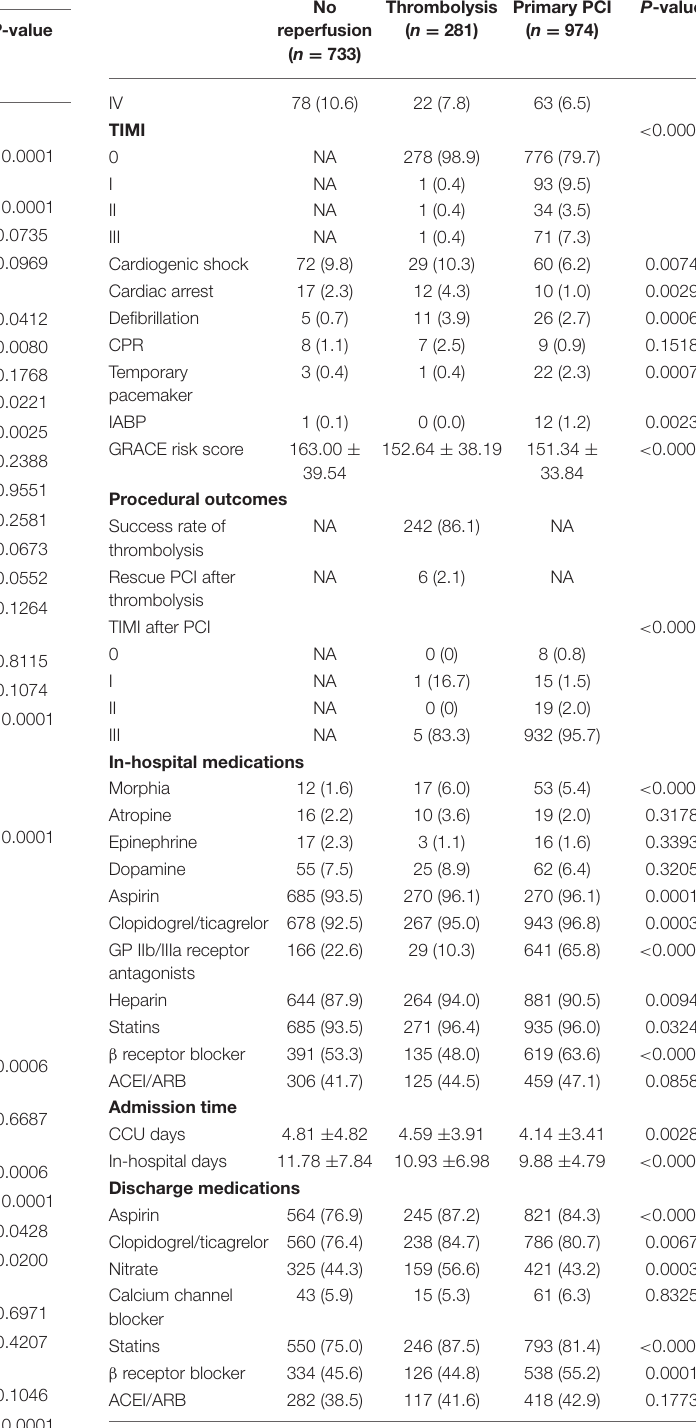
TABLE 1 | Baseline characteristics according to treatment strategies in patients with right ventricular